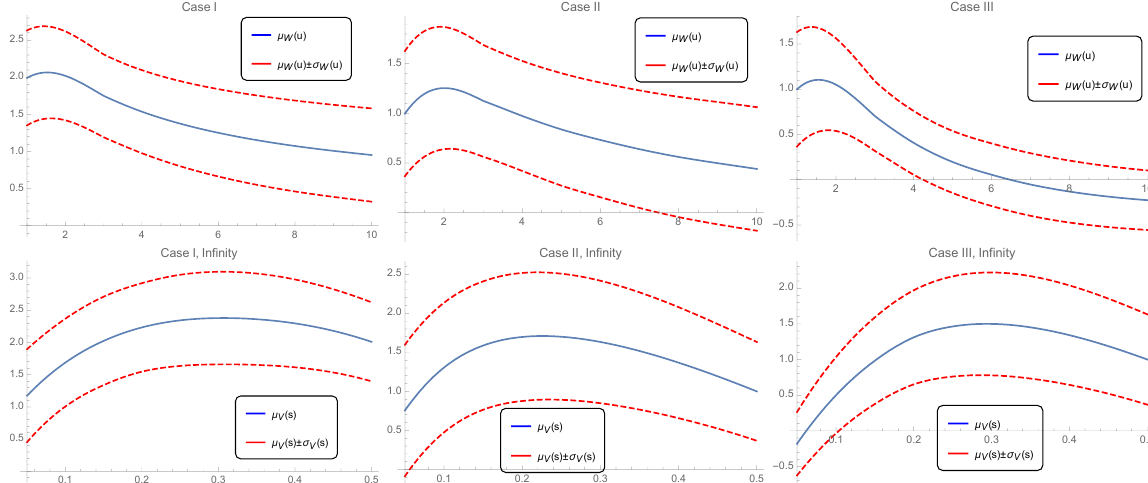
Fig. 2 Top: Plots of the mean, µ W ( u ) , and plus/minus the standard deviation, σ W ( u ) , of the solution SP, W ( u ) , to IVP (4) in Cases I–III at different values of u ∈ [ 1 , 10 ] . Bottom: Plots of the mean, µ V ( s ) , and plus/minus the standard deviation, σ V ( s ) , of the solution SP, V ( s ) , to IVP (17) in Cases I–III at different values of s ∈ [ 0 . 05 , 0 . 5 ]